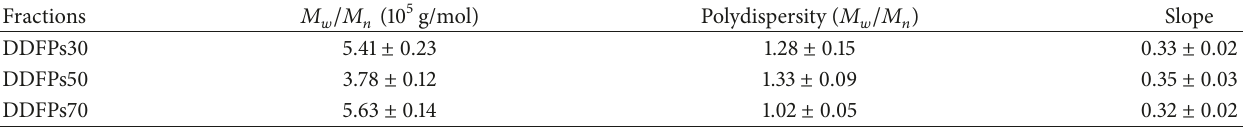
Table 3: The physical properties of polysaccharides from D. devonianum flowers (𝑛 = 3) .